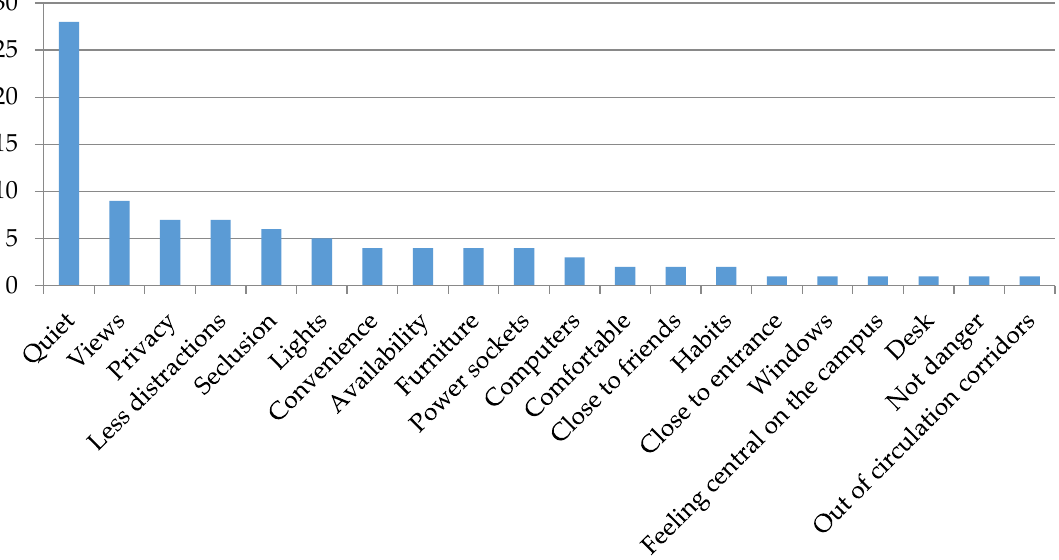
Figure 7. Frequency of reasons being mentioned.